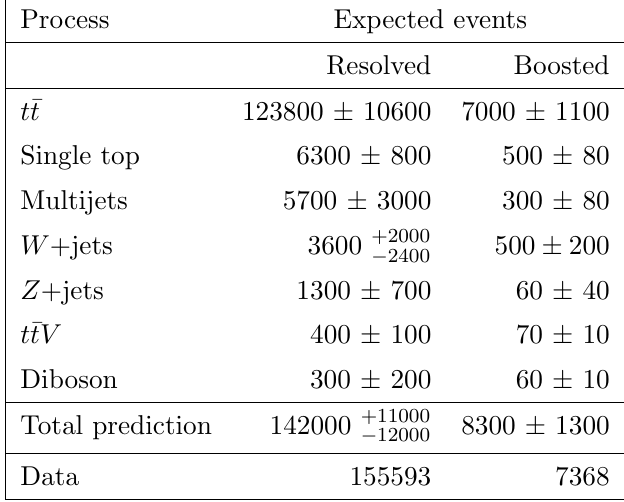
Table 3. Event yields after the resolved and boosted selections. The signal model, denoted t (cid:22) t in the table, is generated using Powheg + Pythia6 , normalised to NNLO calculations. The uncertainties include the combined statistical and systematic uncertainties, excluding the systematic uncertainties related to the modelling of the t (cid:22) t system, as described in section